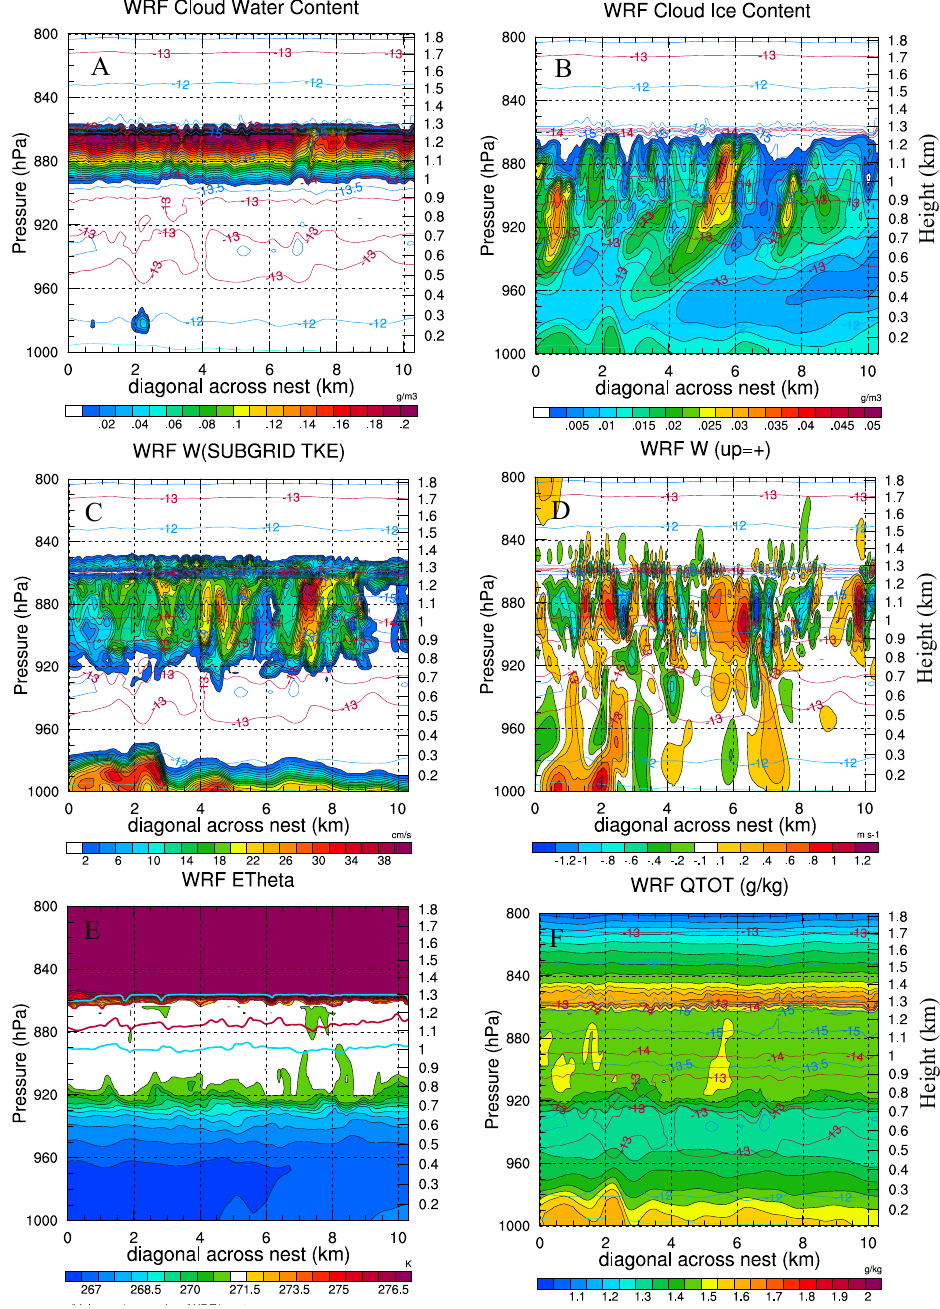
Fig. 7. Vertical structure at 20Z along mean cloud layer wind from 50m nest. (A) Cloud water, in units of gkg − 1 . (B) Cloud ice, in units of gkg − 1 . (C) Subgrid w , in units of cms − 1 . (D) Vertical velocity, in units of ms − 1 . (E) Equivalent potential temperature, in units of K. Red (blue) lines are contours of q c =0.12 (0.01)gm − 3 to identify max (min) of the cloud layer. (F) Total water, in units of gkg − 1 . Isotherms are shown with colored contour lines in all figures except (E)